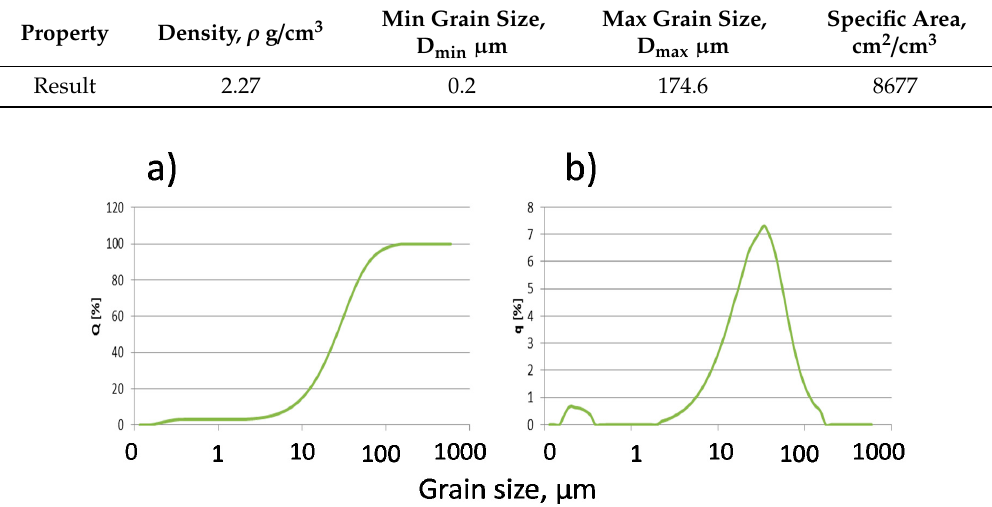
Figure 2. Calcareous fly ash grain size distribution (laser granulometry): ( a ): cumulative curve ( b ): population curve. Table 3. Characteristics of the chemical composition of calcareous fly ash.